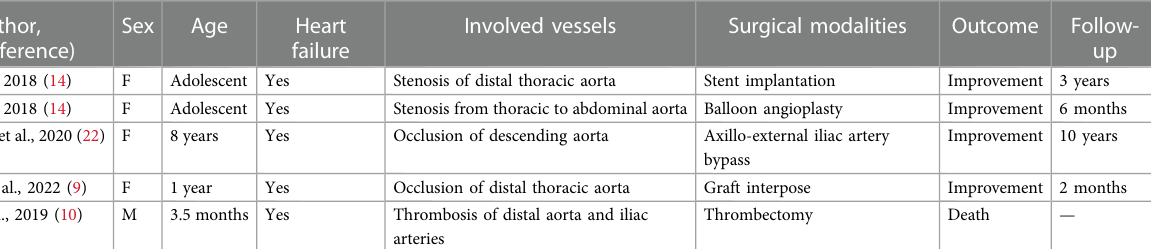
TABLE 1 Review of surgical modalities and outcomes in juvenile Takayasu arteritis involving